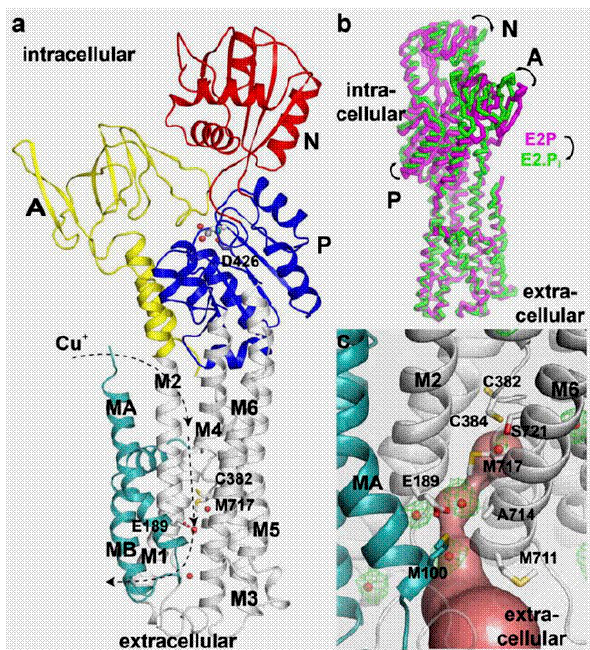
calcium ATPase where the E 10a the A, P and N domains are colored in yellow, blue and red, respectively. The black arrows mark the copper